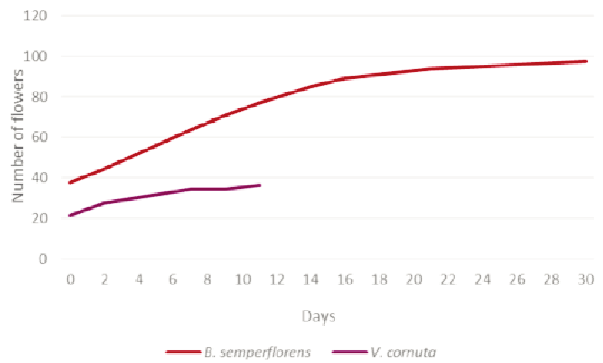
Fig. 2 ­ Flower production of B. semperflorens (red) and V. cor‐ nuta (purple). Data are shown in a cumulative curve.